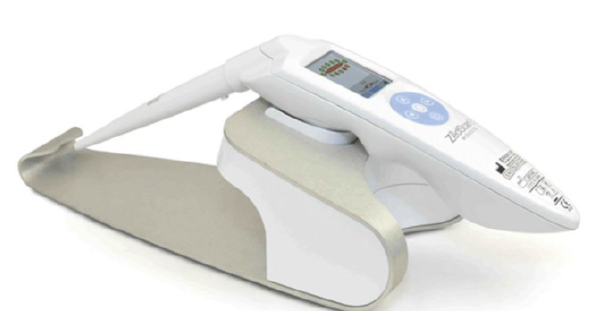
Fig.1: The ZedScan handset for making the EIS measurements used in this paper. The handset is shown placed on the